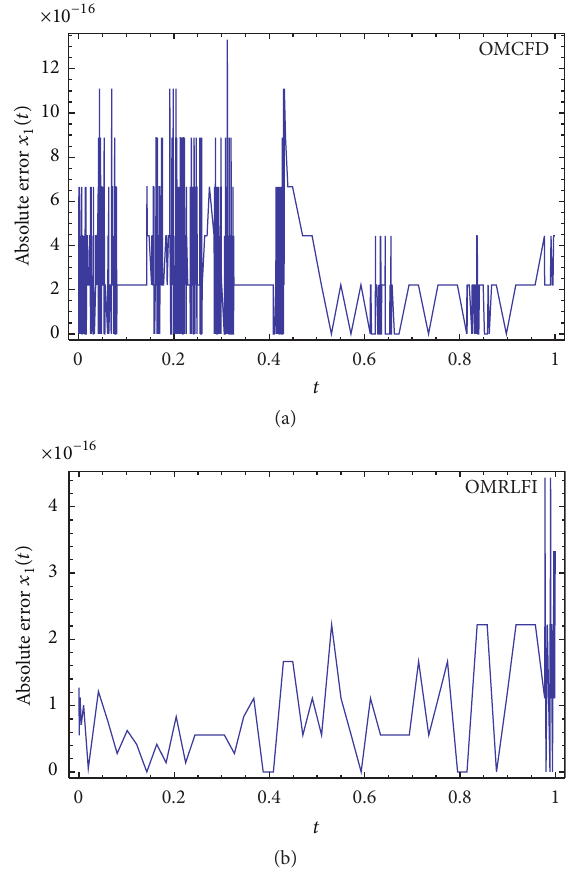
Figure 7: Plot of absolute error function 𝑥 1 (𝑡) for 𝛼 1 = 𝛼 2 = 1 and 𝑚 = 10 by OMCFD and OMRLFI in Example